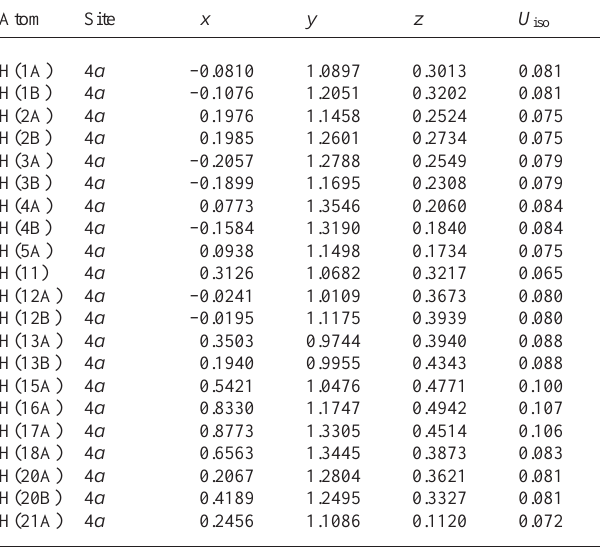
Table 2. Atomic coordinates and displacement parameters (in Å 2 )